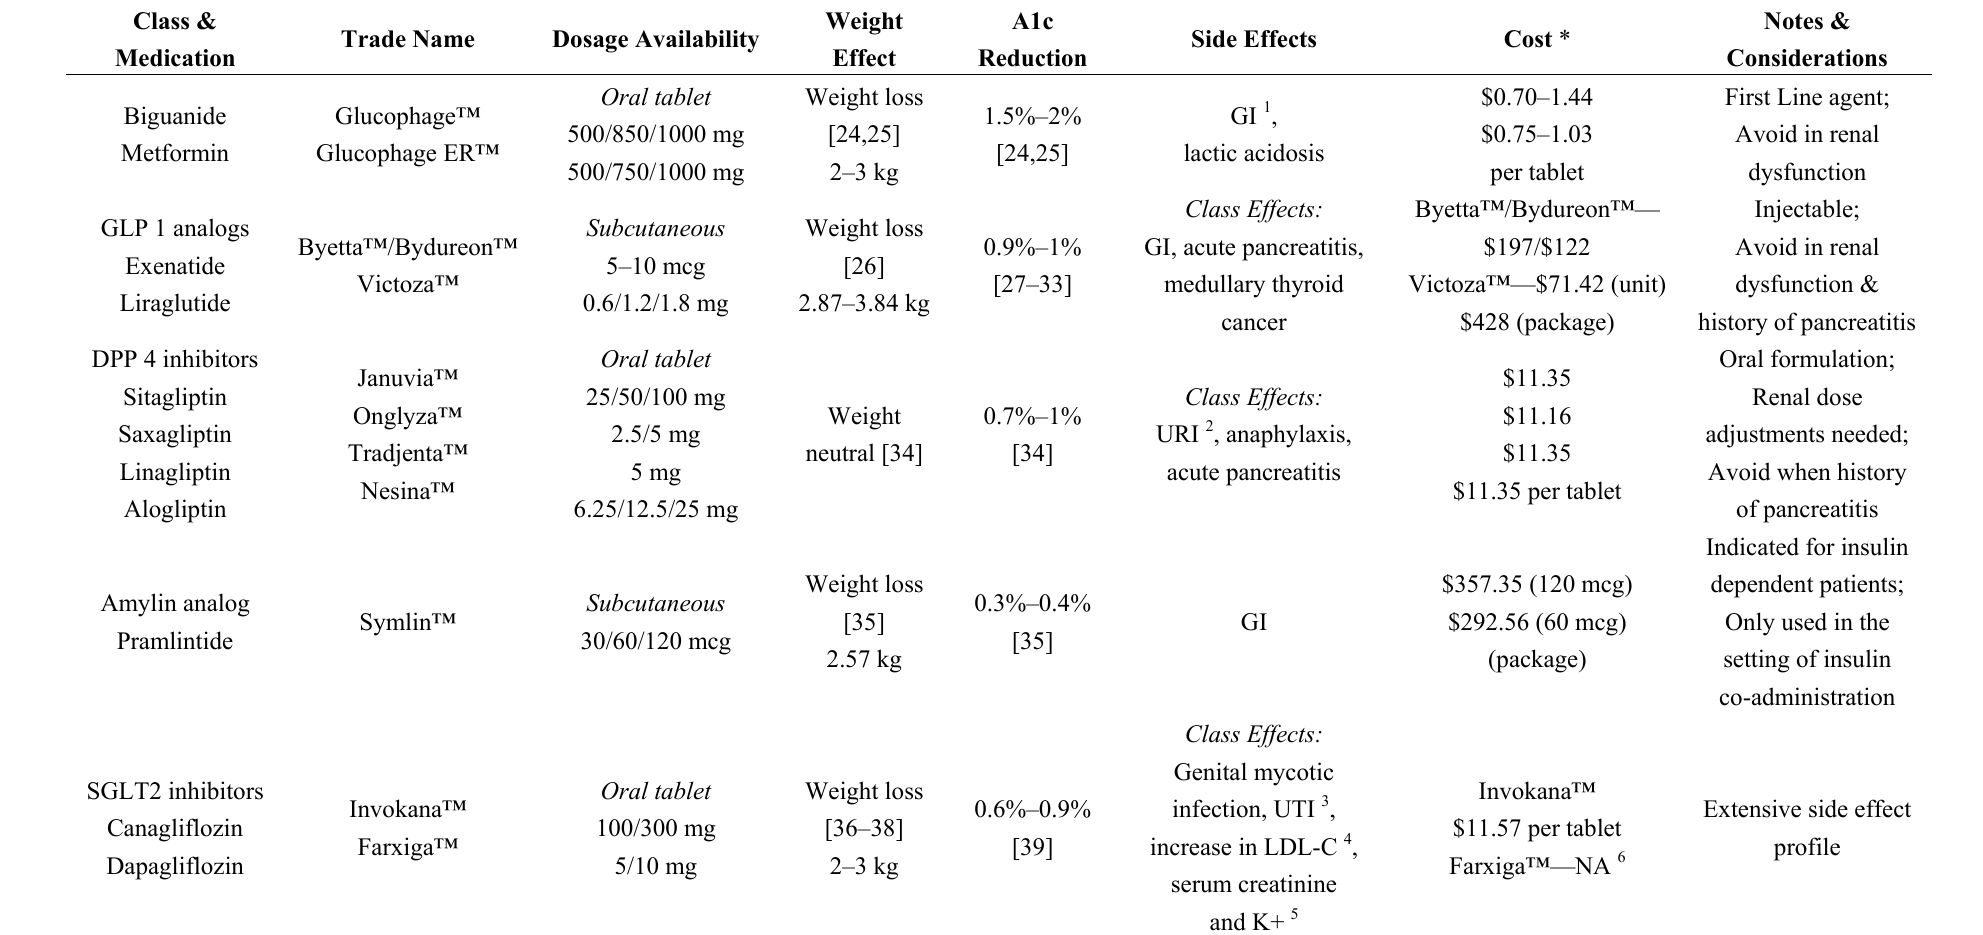
Table 1. Anti-diabetic agents with beneficial effects on